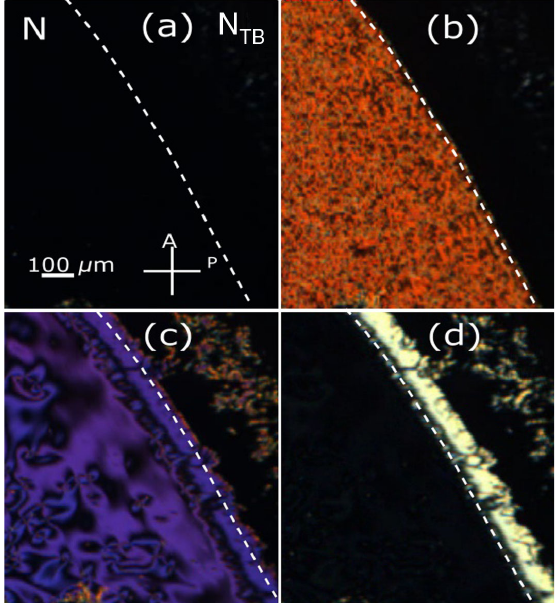
FIG. 3. Polarizing microscope textures for a 5- μ m-thick ho- meotropically aligned sample of the studied mixture. The optic axis is normal to the image plane, and the sample is placed between crossed polarizers. (a) Separate regions of N and N phases observed at the transition between the two; the boundary is marked by the dashed line. Both regions are uniform and dark, indicating high-quality homeotropic alignment of the director ˆ n in the nematic and pitch axis ˆ t in the N applied ac voltage (5 V @ 10 KHz), a second-order Freedericsz transition (reorientation of ˆ n in the center of the sample) is observed in the nematic region, while the N unchanged. (c) Under higher voltage (7 V @ 10 KHz), the N region undergoes a first-order reorientation of ˆ t in the form TB of nucleating toroidal focal conic domains (FCDs) and expanding stripes of splay and saddle-splay deformations of ˆ t . (d) Several seconds after the voltage has been switched off, the nematic region relaxes back to the homeotropic state, whereas the N region relaxes considerably slower.